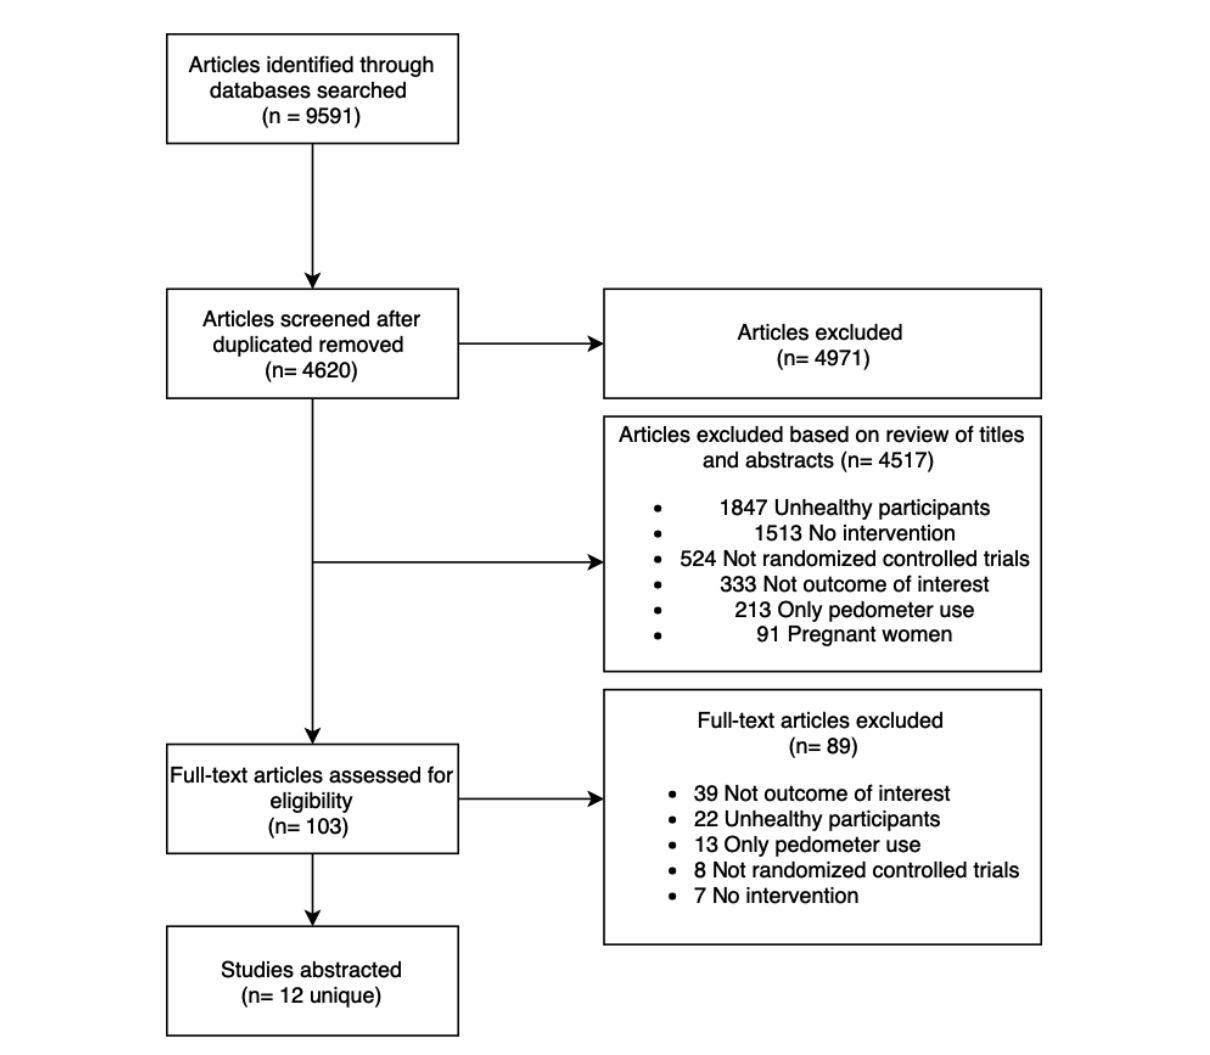
Figure 1. PRISMA Flow